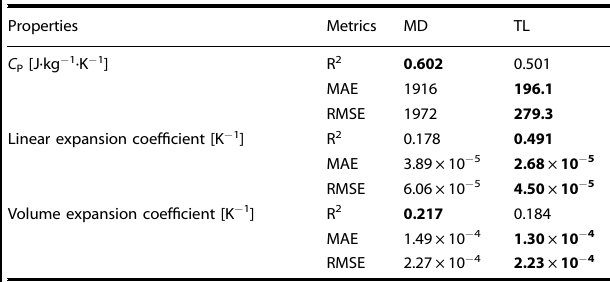
The bold values indicate the best result for prediction